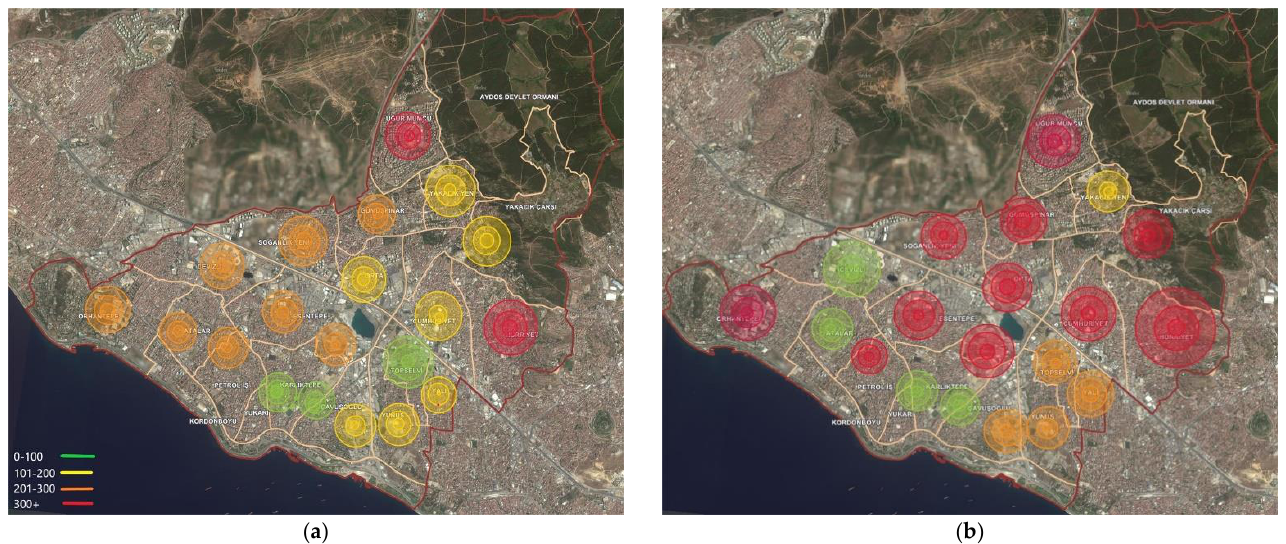
Figure 6. The average number of unserved casualties at demand points according to ( a ) the proposed and ( b ) the existing system.